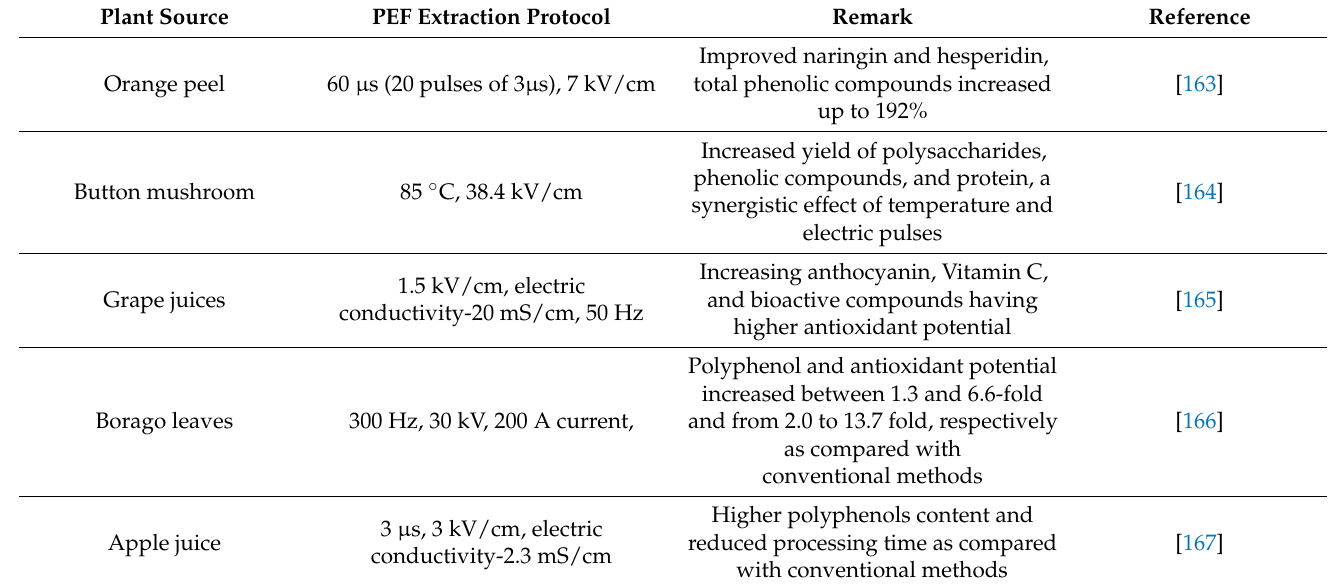
Table 8. Pulse electric field (PEF)-assisted extraction of bioactive compounds from plant biomass. Plant